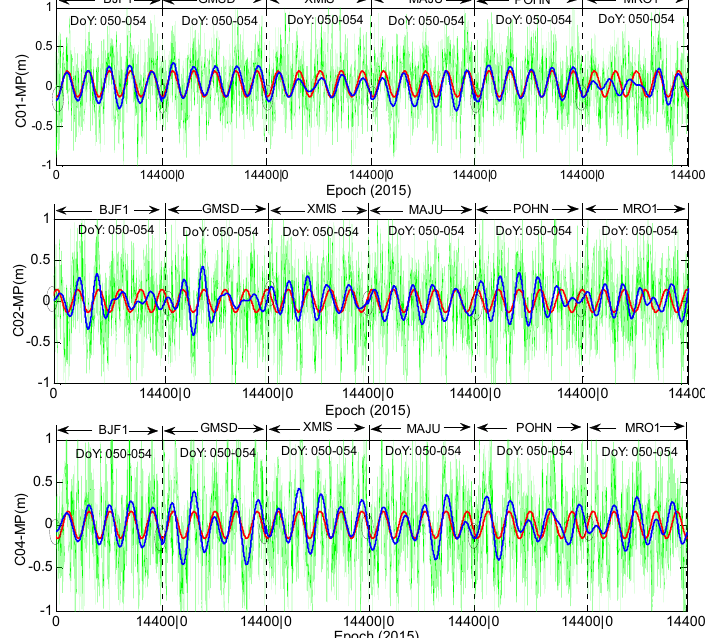
Figure 5. The multipath series of C01, C02 and C04 at the other six stations. Green is the multipath estimation; red is the Fourier fitting results of the multipath series; blue is the wavelet reconstructed multipath series; the cycle is the edge of reconstructed multipath series between different stations. The observation sampling rate is 30 s.